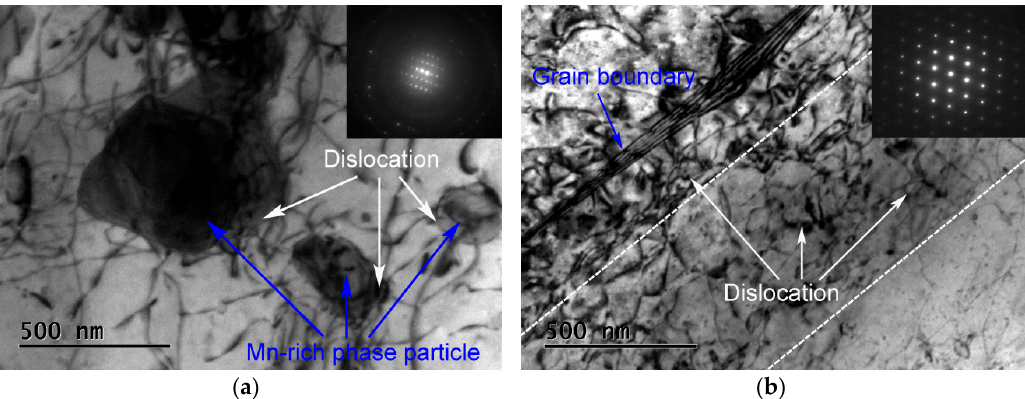
Figure 12. Location of dislocations, precipitated particles ( a ), and grain boundaries ( b ) in TEM images at T = 500 °C and ε = 1 × 10 − 3 s − 1 with ε = 0.65.